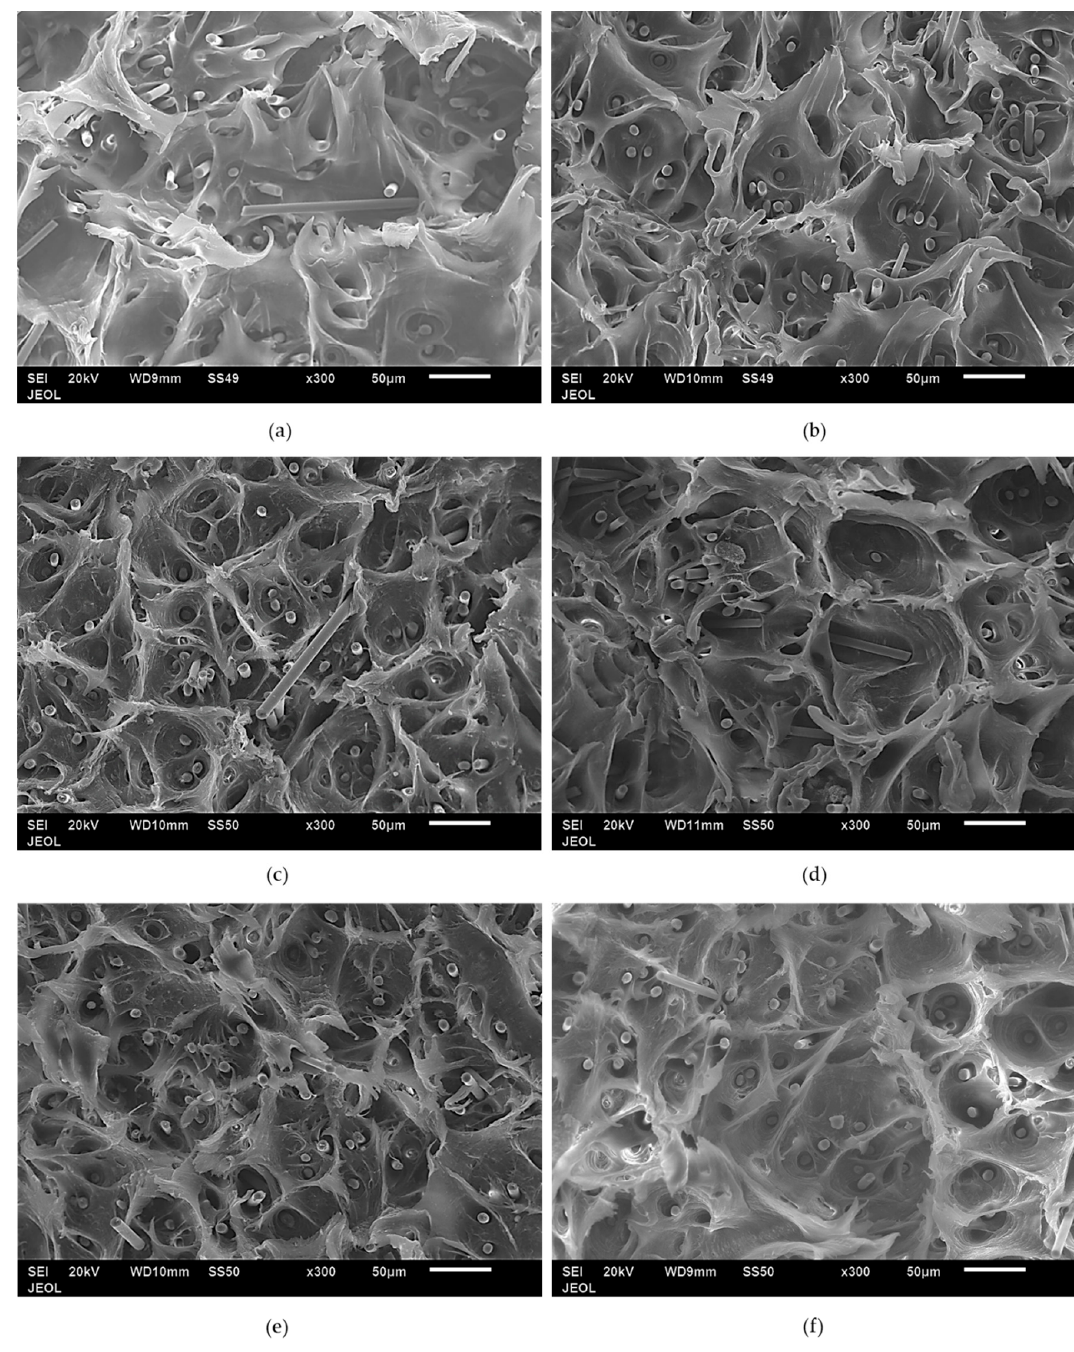
Figure 8. SEM images of tensile test fracture surfaces ( a ) PP / 10SCF, ( b ) PP / 15SCF, ( c ) PP / 10SCF / 5GNP, ( d )PP / 10SCF / 5nTiO 2 , ( e ) PP / 10SCF / 4GNP / 1nTiO 2 and ( f ) PP / 10SCF / 2.5GNP / 2.5nTiO 2.